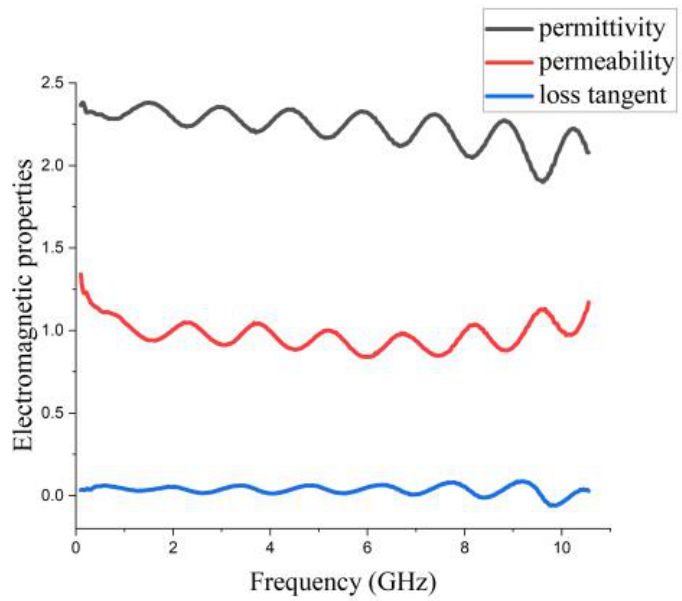
Figure 2. Measured permittivity and permeability.